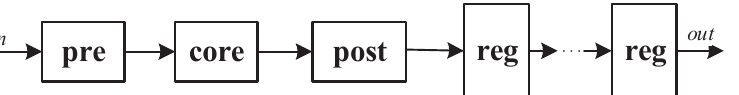
Figure 11. Pipelined architecture of hardware by adding several registers after the original hardware design, where pre represents the preprocessing module, core represents the core computing unit, post represents the postprocessing module and reg represents the